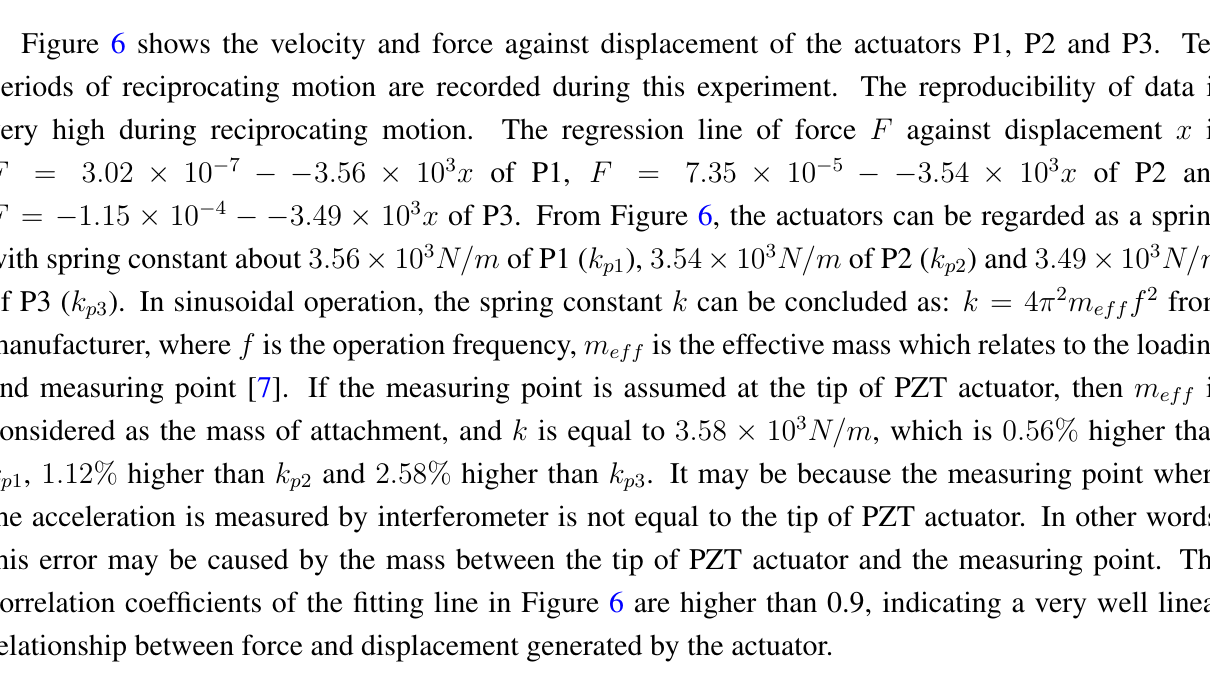
Figure 6. Velocity and force changed against displacement; ( a ) P1; ( b ) P2 and ( c )